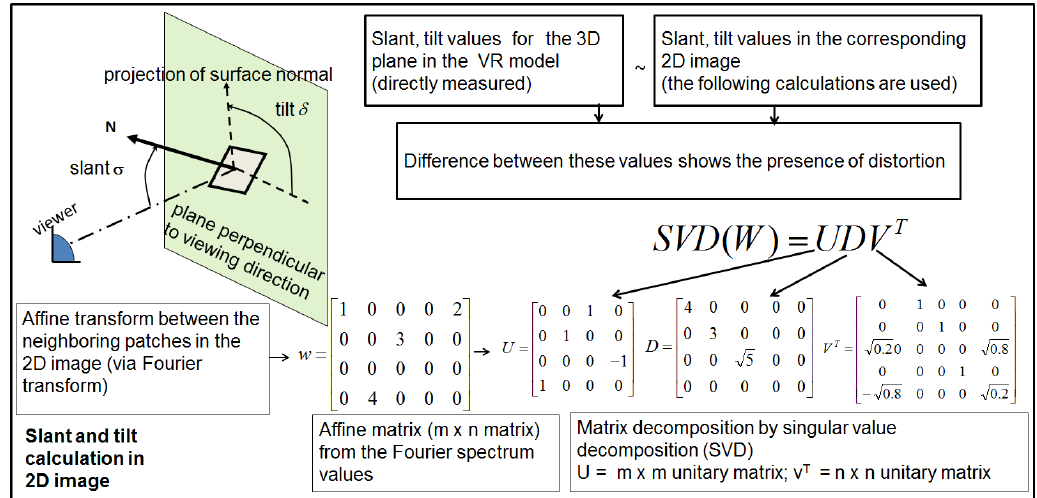
Figure 2: Virtualized reality indoor model and occlusion and distortion handling